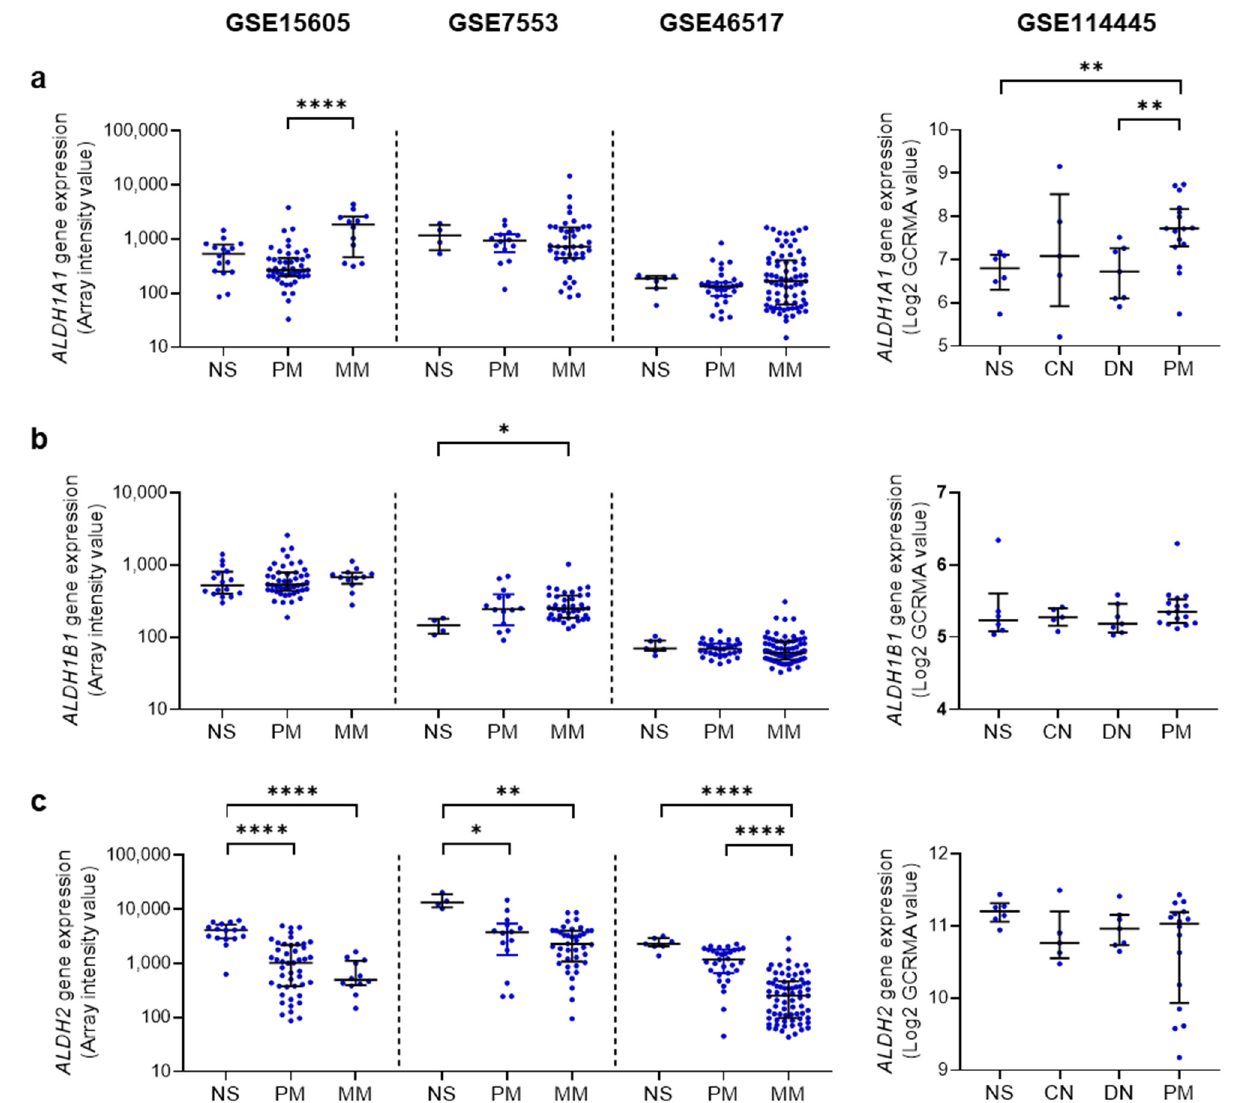
Figure 4. Gene expression of acetaldehyde (AcAH) metabolizing enzymes in normal human skin, melanocytic nevi, and melanoma. AcAH metabolizing enzyme genes include ALDH1A1 ( a ), ALDH1B1 ( b ), and ALDH2 ( c ). See Figure 3 for CYP2E1 . Data from four independent gene profiling studies were analyzed as described in Figure 3: GSE15605 (16 normal skin (NS) samples, 46 primary melanoma (PM) samples, and 12 metastatic melanoma (MM) samples [149]), GSE7553 (4 NS, 14 PM, and 40 MM [150]), GSE46517 (7 NS, 31 PM, and 73 MM [151]), and GSE114445 (6 NS, 5 common nevus (CN) samples, 7 dysplastic nevus (DN) samples, and 16 PM [152]). Data are shown as scatter dot plot with median and interquartile range (IQR). * p < 0.05, ** p < 0.01, and **** p < 0.0001 (Kruskal–